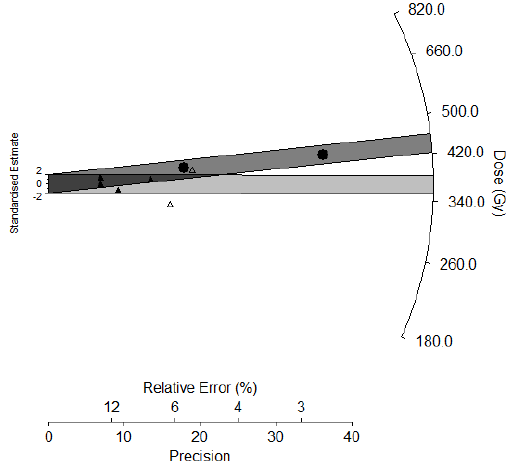
Figure B3. Radial plot showing the doses of accepted aliquots for the coarser-grained sample L20 (A0113). Aliquots run using the IR50 preheat are shown as black circles, with the darker grey shaded area; those run using the higher-temperature preheat are shown as open triangles, and the CAM age shaded in lighter grey.